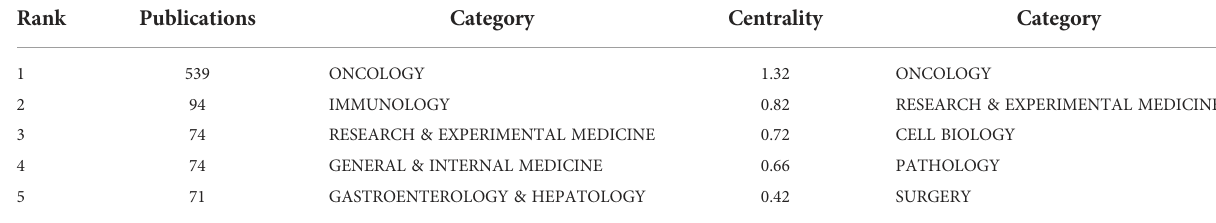
Data were retrieved from 552 publications with CiteSpaceV on June 20, 2022.